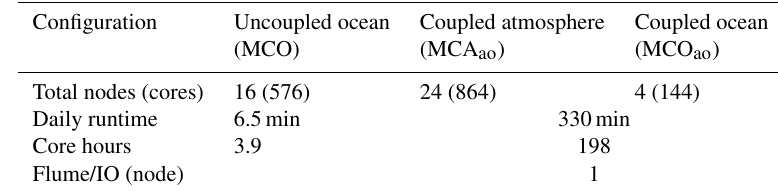
Table 1. Summary of HPC resources usage and typical runtimes.